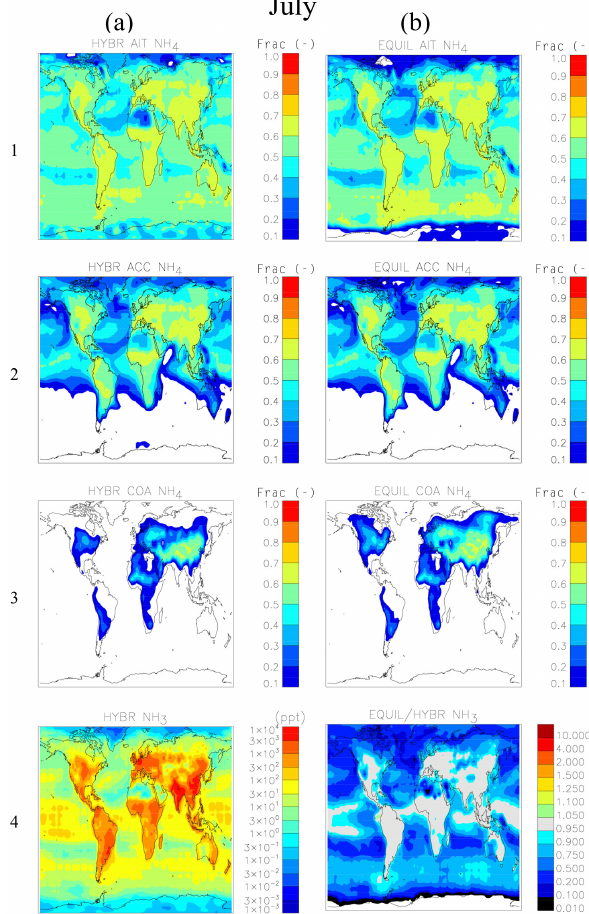
Figure 14. Top to bottom, July 2003 ground level nitrate fraction (–) in the Aitken (1), accumulation (2) and coarse (3) mode, and ni- tric acid gas-phase (4) mixing ratio (ppt), obtained with the hybrid ( a , on the left) and the equilibrium ( b , on the right) configuration of HyDiS-1.0. The equilibrium gas-phase mixing ratio is shown rela- tive to the hybrid results.